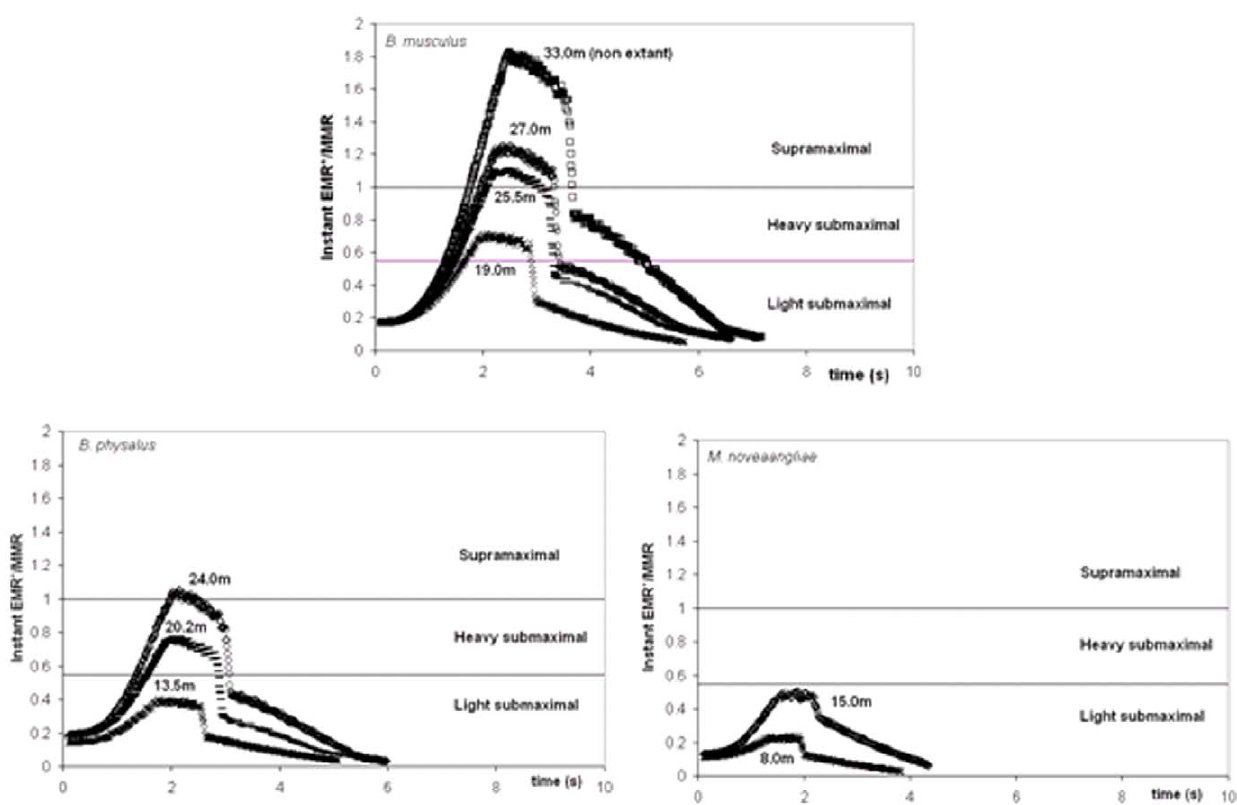
Figure 12. Comparing instant mouth opening EMR* with MMR. EMR* corresponds to equation 1 with the energies integrated over time slices of 0.1 s durations, but without the X- and Y-terms.